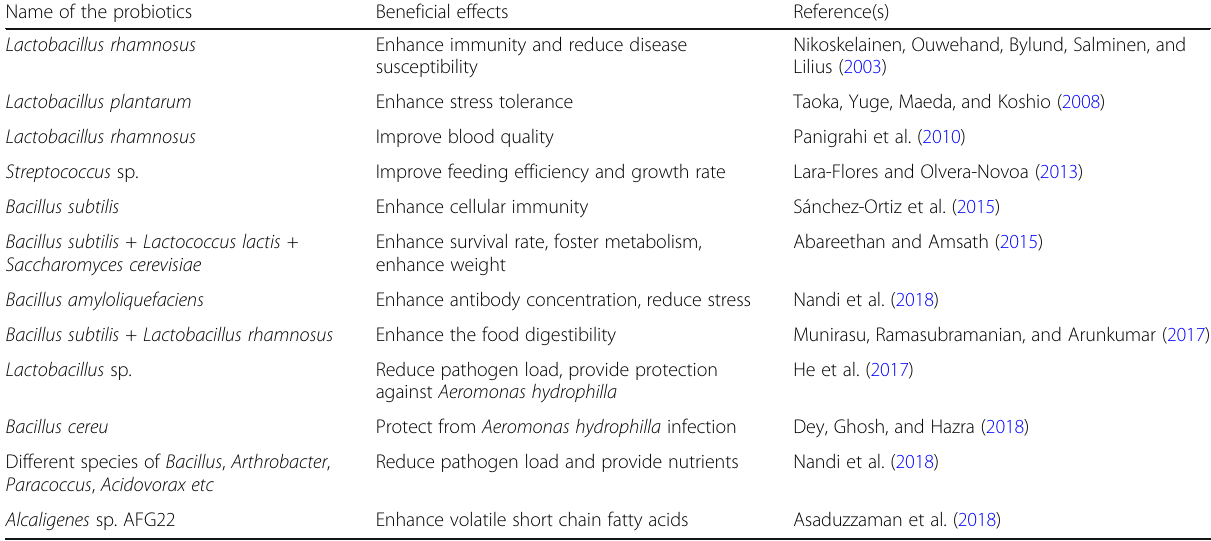
Table 1 Gut probiotics and their beneficiary effects on aquatic organisms Name of the